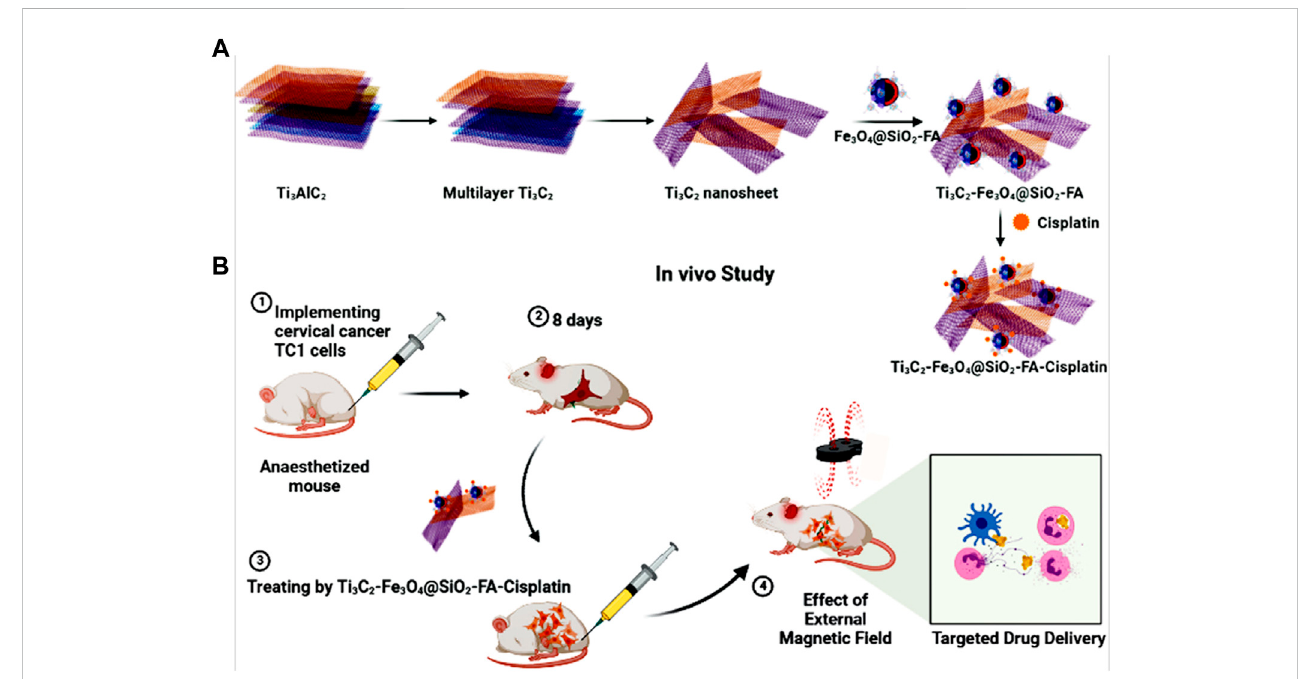
FIGURE 1 (A) Fabrication of Ti 3 C 2 -Fe 3 O 4 @SiO 2 -FA-Cisplatin, (B) Cisplatin targeting for cervical cancer delivery in vivo